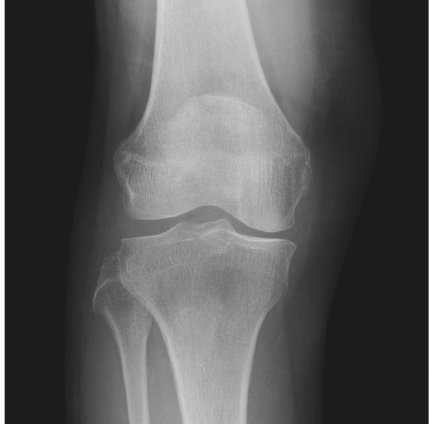
Figure 1: The anteroposterior radiograph of right knee at the onset showing no abnormal finding.